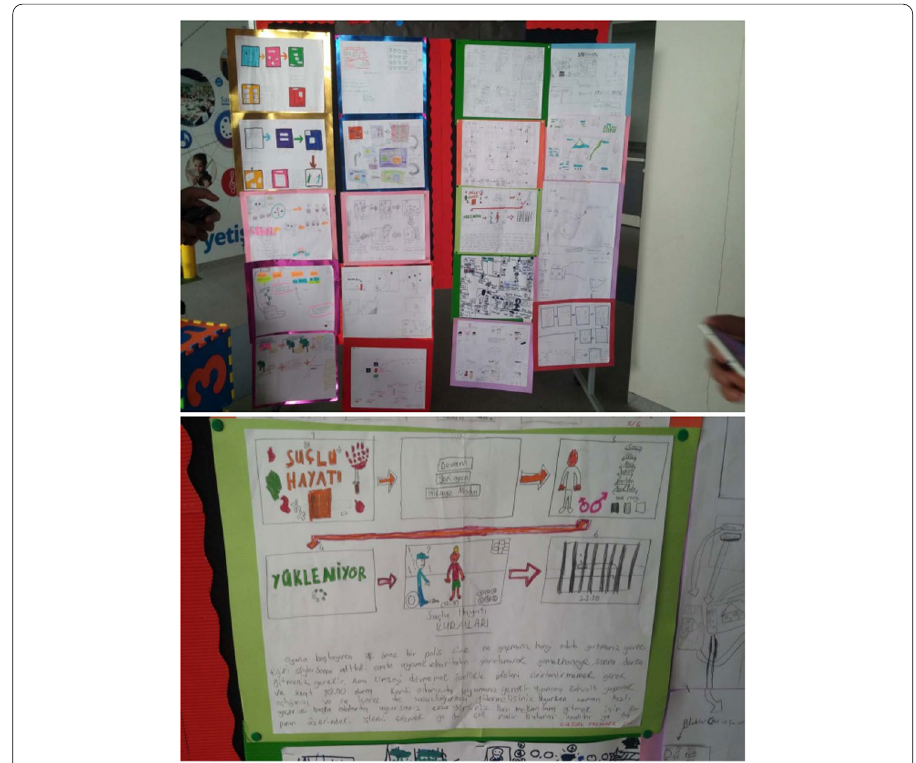
Fig. 1 Participants’ game design product on